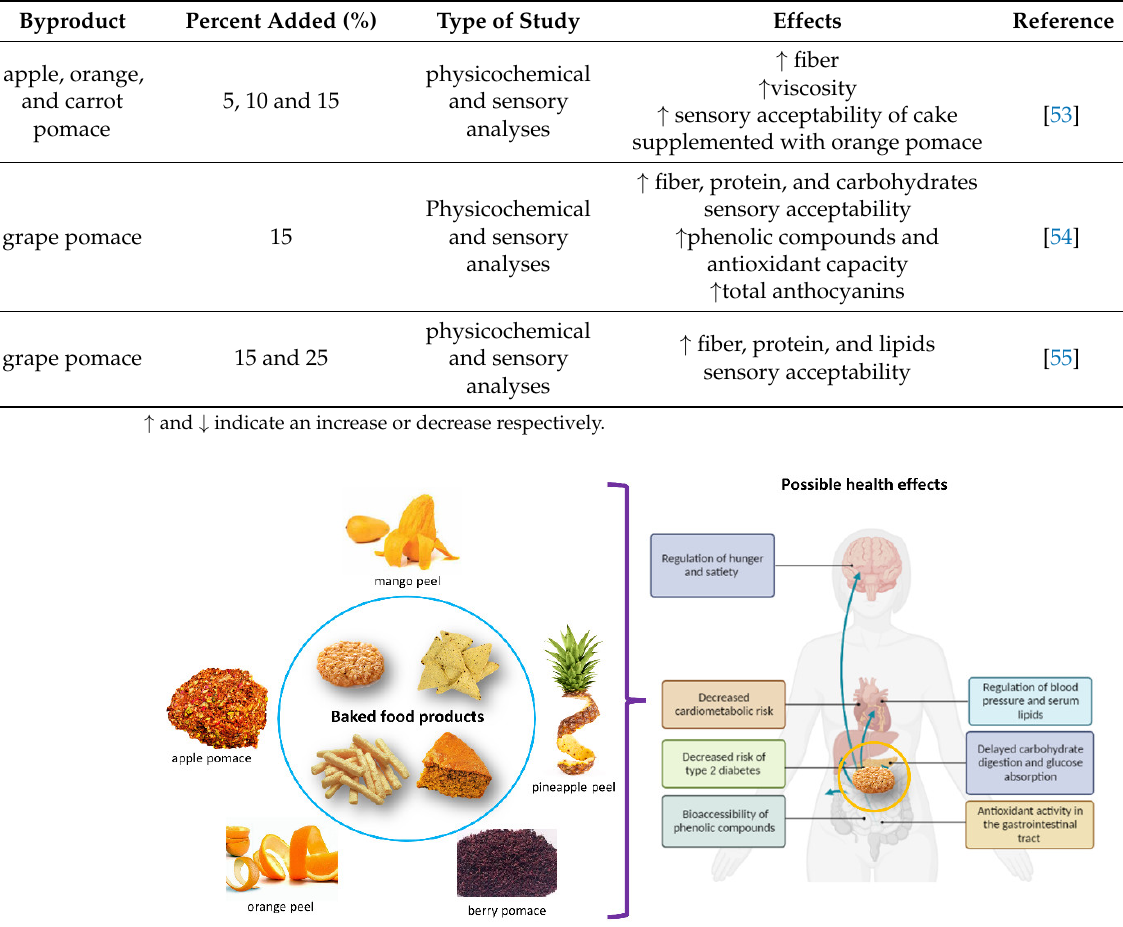
Figure 1. Examples of agro-industrial fruit byproducts that have been used to supplement baked food products (biscuits/cookies, corn chips, extruded snacks, and cakes) and some possible health effects that these can induce on the consumer.